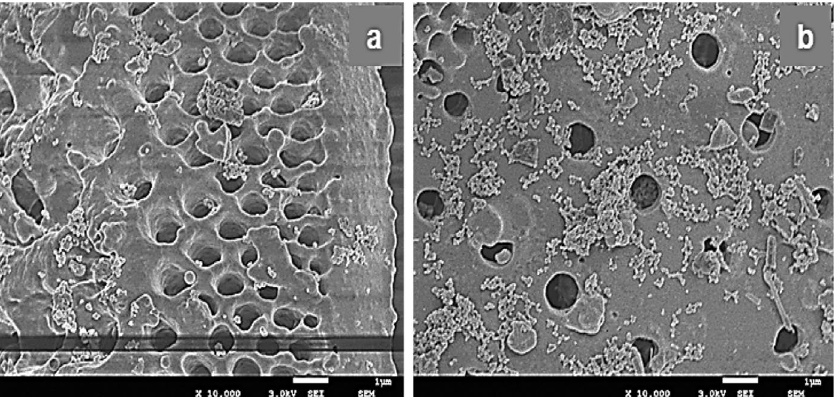
Figure 4. SEM image of DE mixed with calcium carbonate or sepiolite/nano-TiO 2 . ( a ) calcium carbonate + DE + titanyl sulfate 0.01 mol/L + urea 0.1 mol/L; ( b ) sepiolite + DE + titanyl sulfate 0.01 mol/L + urea 0.1